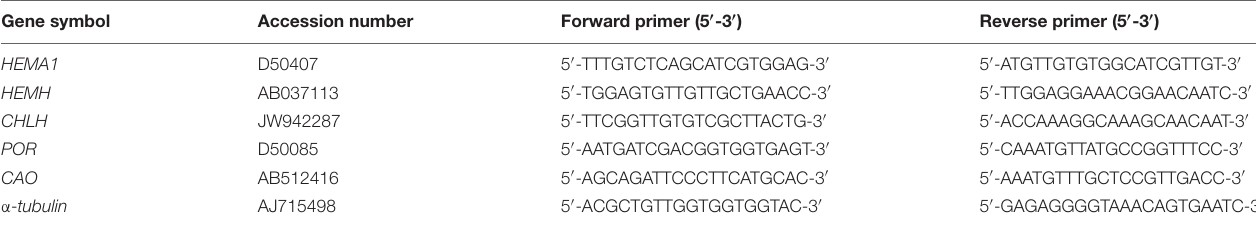
TABLE 1 | Primer sequences and Genebank accession number of the HEMA1 , HEMH , CHLH , POR , CAO and α -tubulin gene sequences. Gene